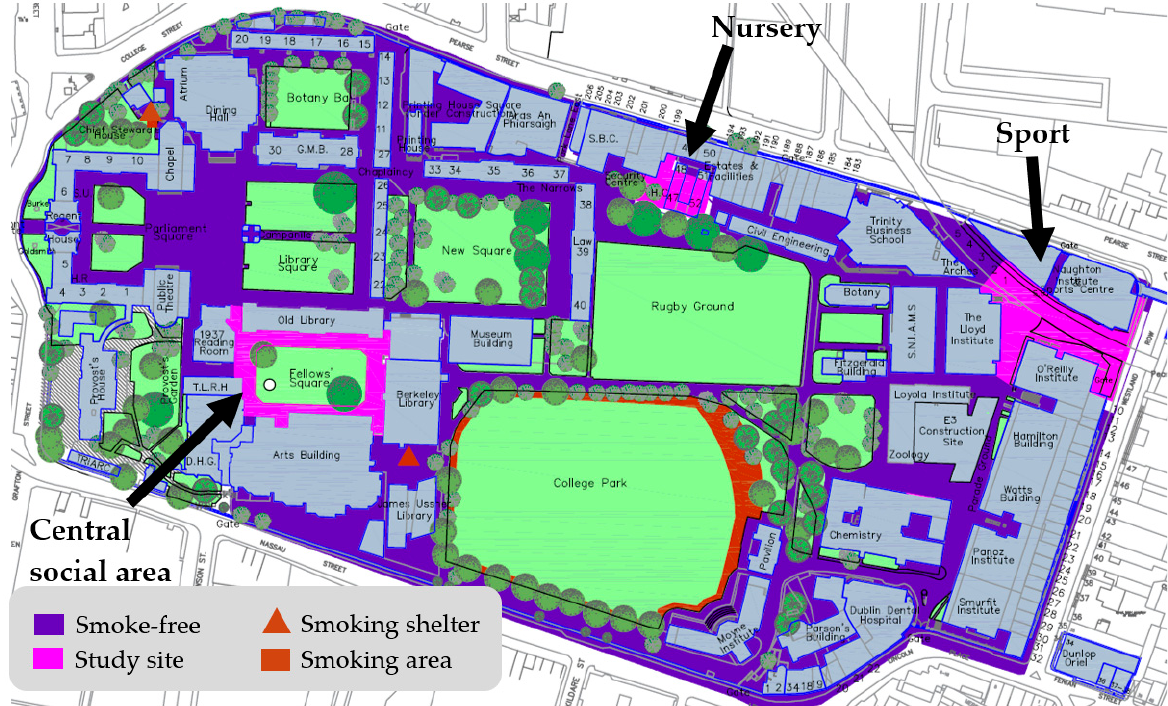
Figure 1. Campus map showing study sites at which baseline and compliance data were collected over a four-year